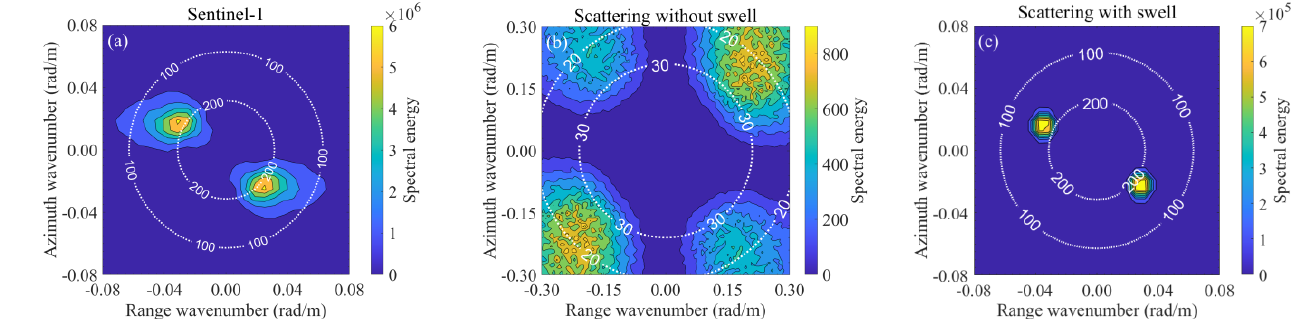
Figure 18. The scattering image spectra corresponding to ID 1 of ( a ) the Sentinel-1 data, ( b ) simulation based on modified TSM + Tayfun sea surface without swell, and ( c ) simulation based on modified TSM + Tayfun sea surface with swell. Table 2. The wavelength and direction of dominant wave obtained from the scattering image spectra in Figure 18.